Question: From the figure, is the trend upward or downward?
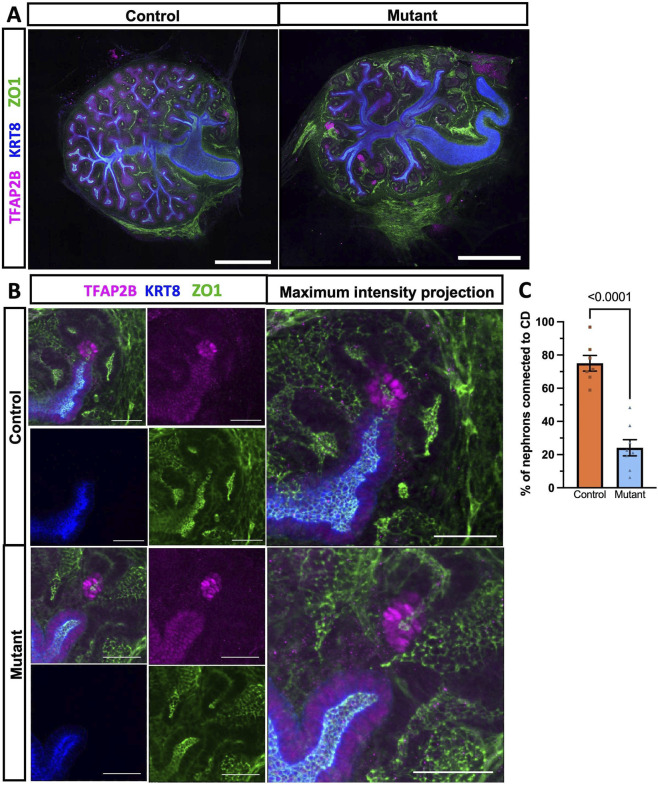
Answer: decreasing